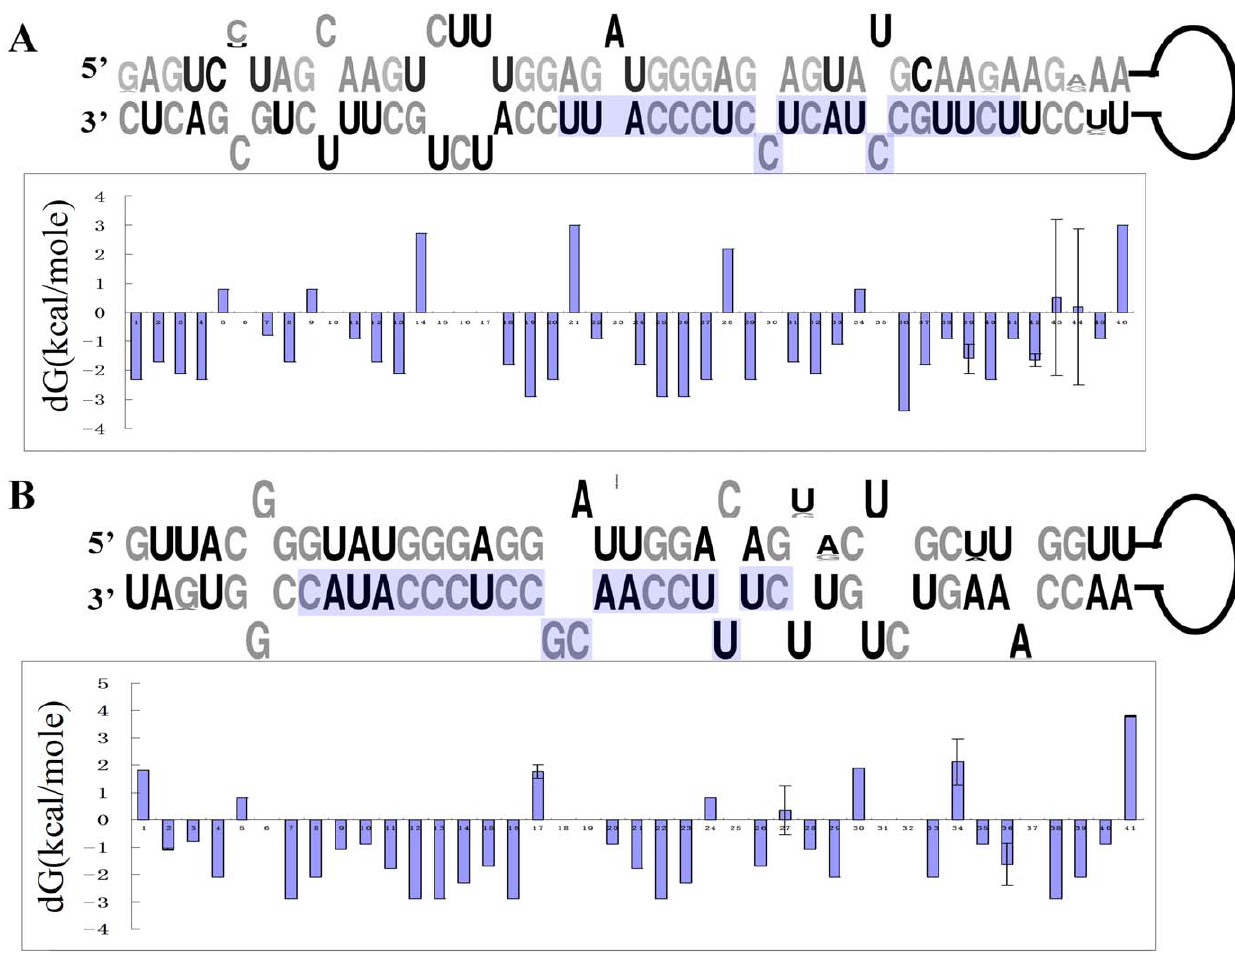
Figure 3. The stem-loop structure and thermodynamic stability of the pre-miR482 and pre-miR1448 in Populus . Free energy values are given in kcal/mole. Vertical bars indicate between-species variability calculated as the double standard error. The mature sequences of miR482.2 and miR1448 were highlighted in light blue.